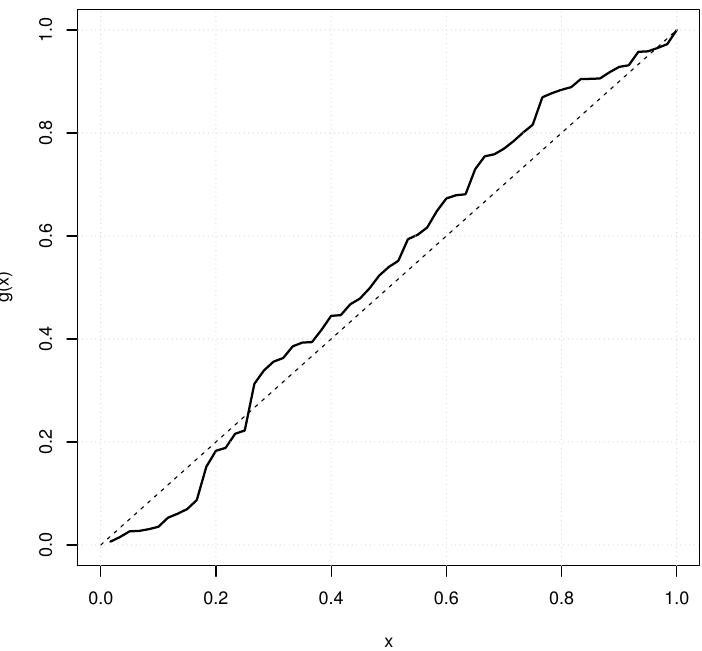
Figure 3. The empirical scaled TTT plot of the failure times in Table